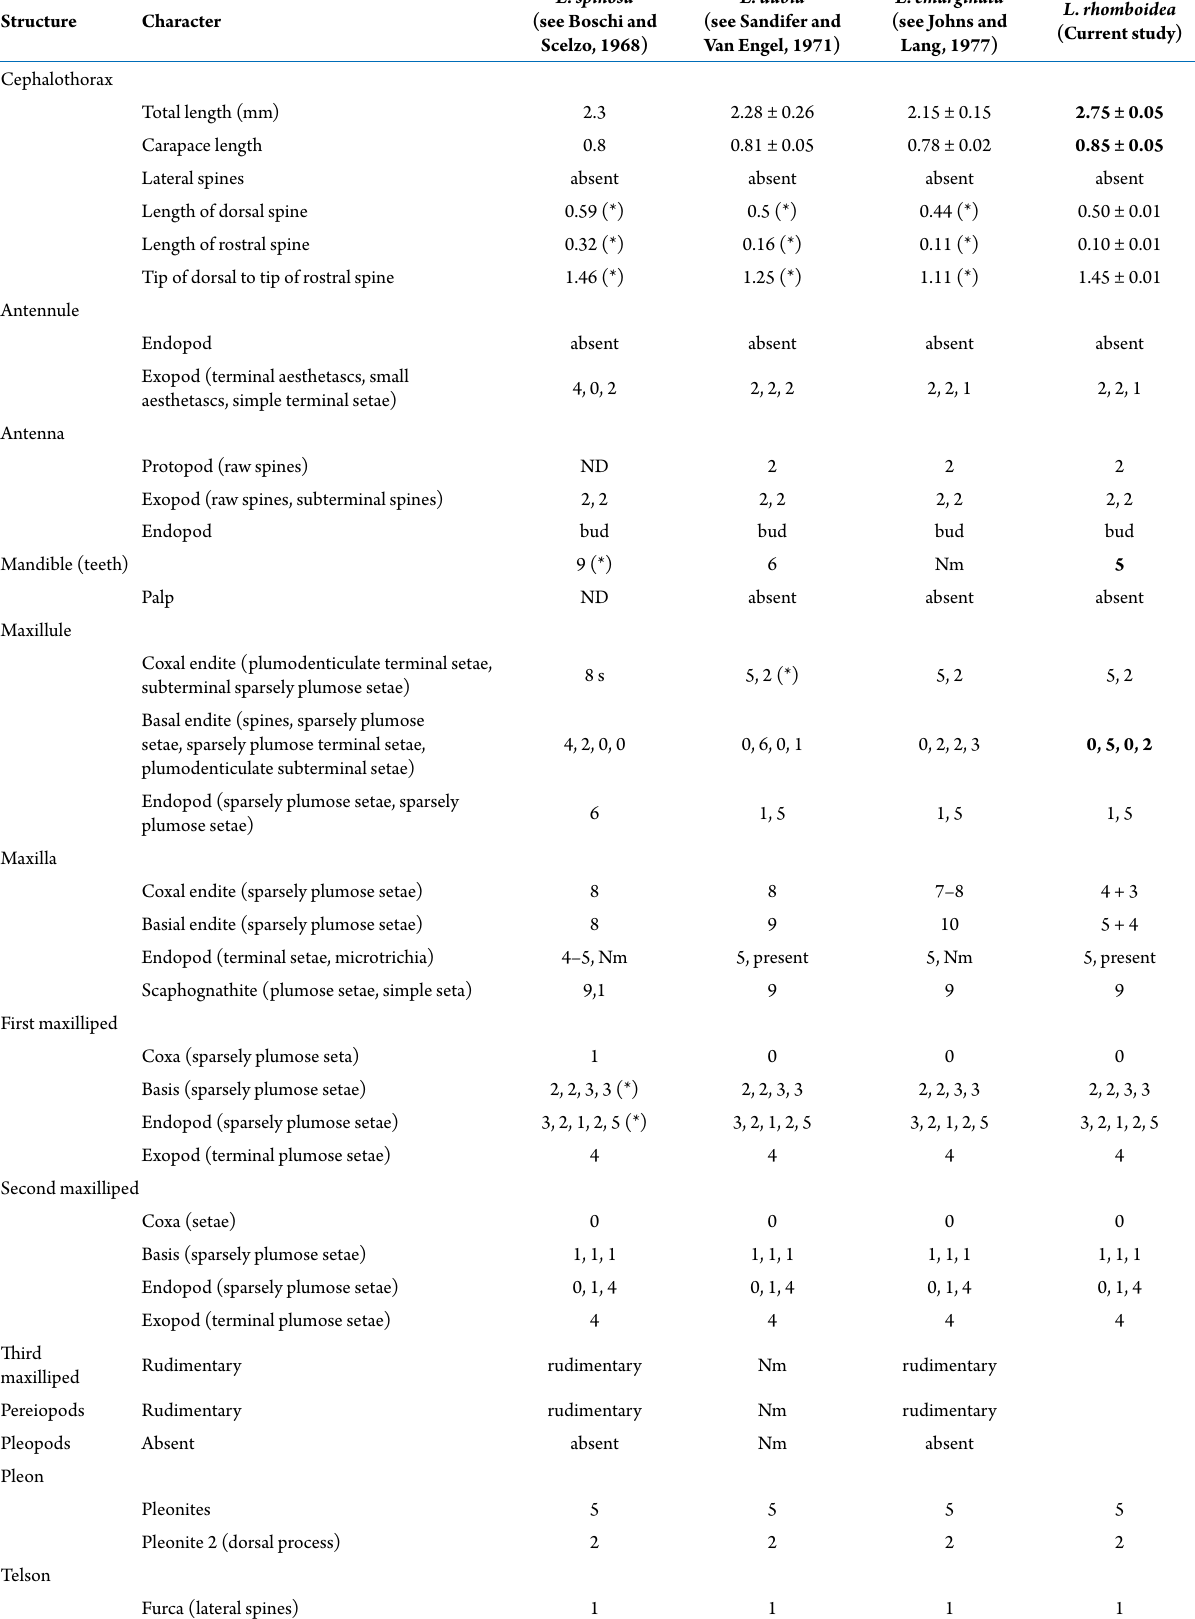
Table 1. First zoea of Libinia spp. Character comparison of four species. ND, not described; Nm, not mentioned; (*) obtained from the figure. Bold type indicates observed